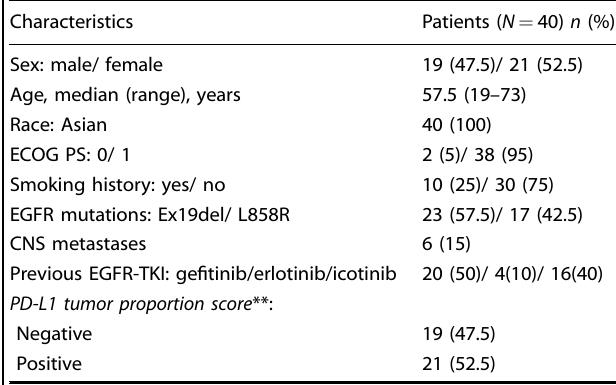
Table 1. Summary of patient